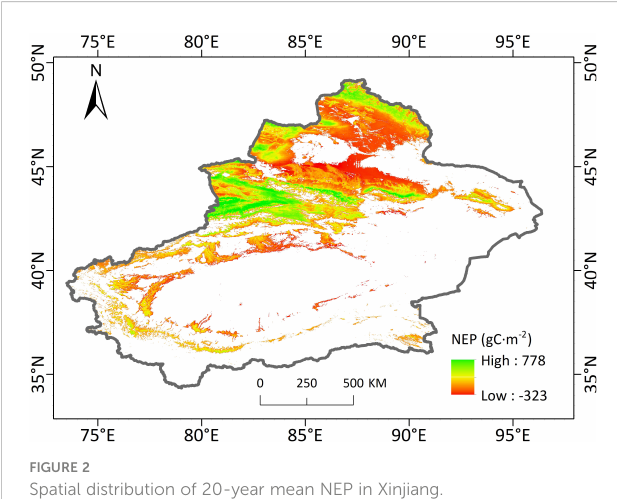
FIGURE 2 Spatial distribution of 20-year mean NEP in Xinjiang.